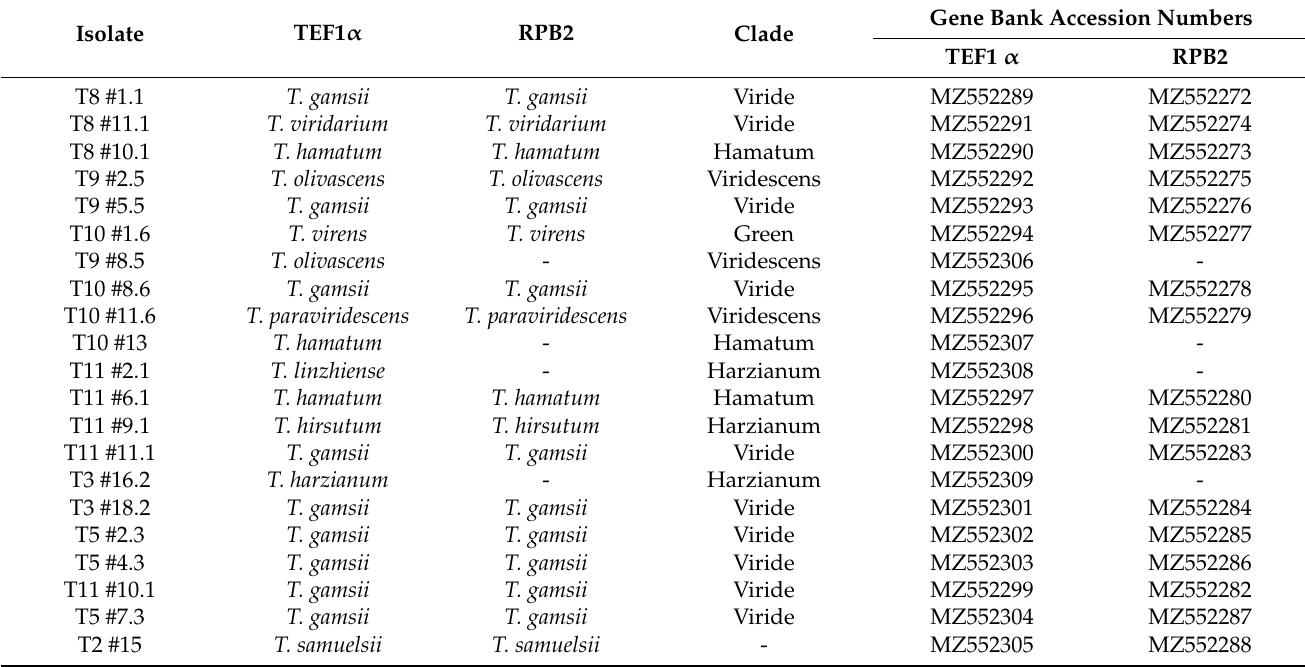
Table 3. Trichoderma species found in the 11 selected trees, identified through amplification of the translation elongation factor 1 alpha gene (tef1 α ) and the RNA polymerase II subunit (rpb2) gene.